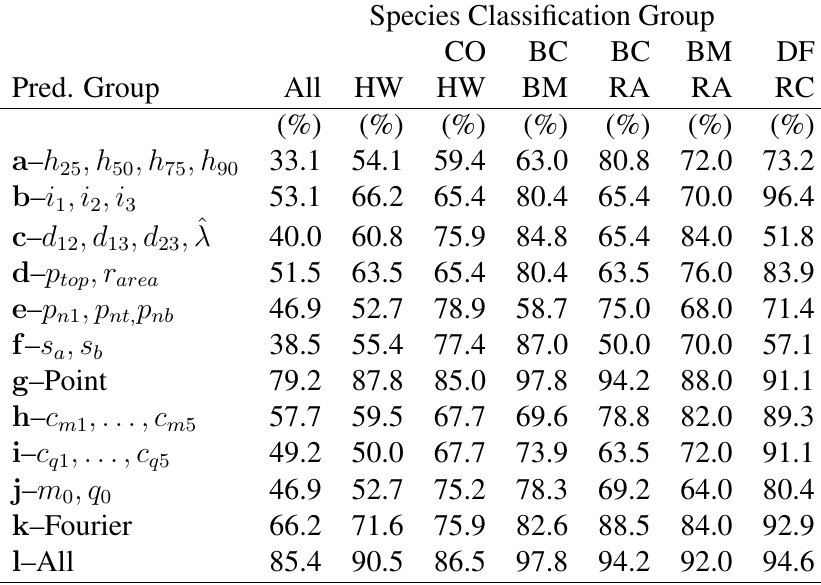
Table 5. Overall percent classification accuracy results of the support vector machine applied with a five-fold cross validation to different predictor variable groups and species